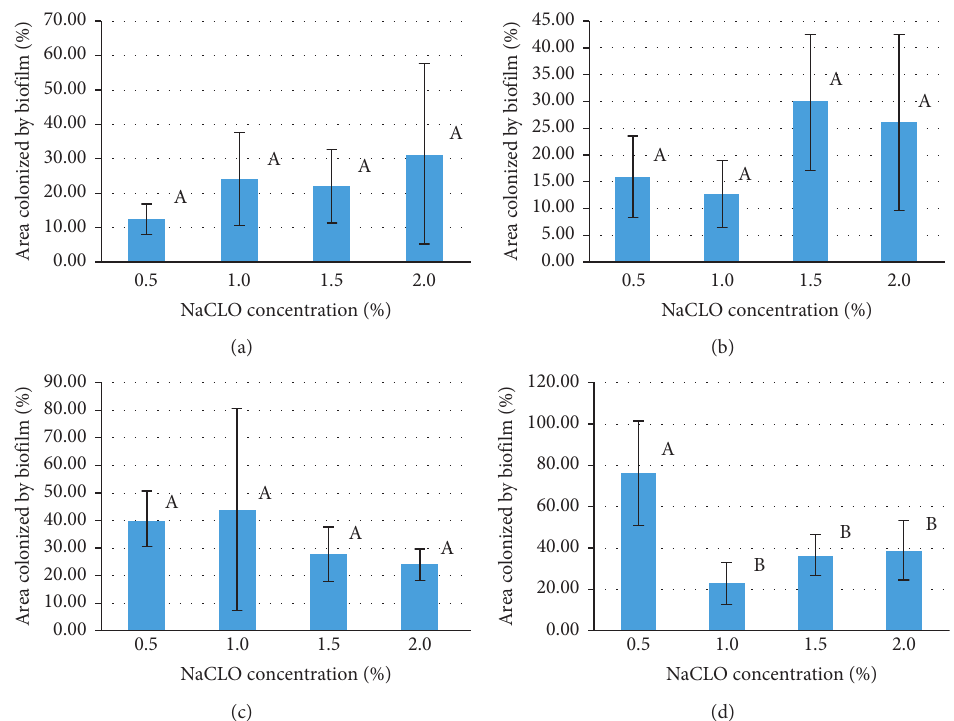
Figure 10: The percentage of the area colonized by P. aeruginosa on the granite Gris Pinhel after 5 (a), 10 (b), 15 (c), and 30min (d) of NaCLO